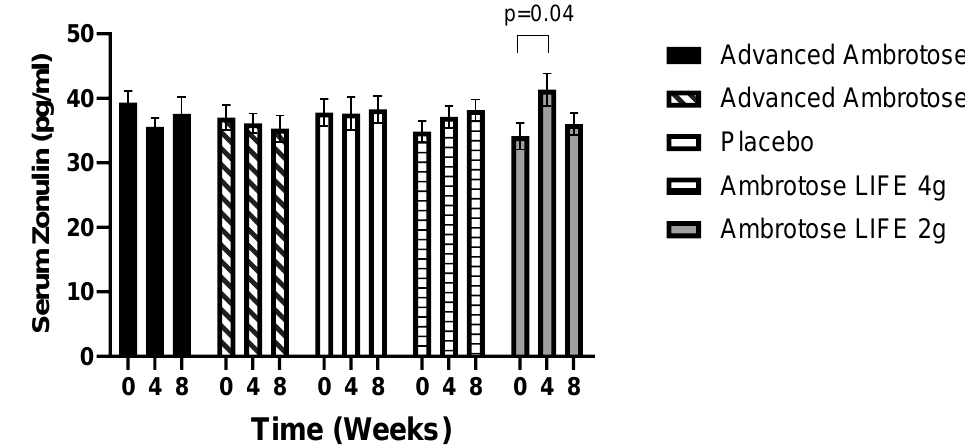
Figure 1. Serum Zonulin concentrations of healthy men and women at baseline and four and eight weeks after supplementation. Values are mean ± SEM, n = 15 per group. Ambrotose LIFE 2 g was significantly different between baseline and four weeks of supplementation ( p = 0.04).